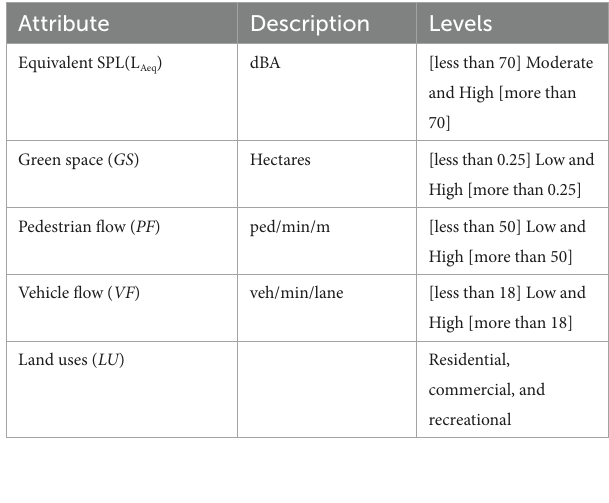
TABLE 2 Factors, indicators, and variables. TABLE 3 Attributes considered in the